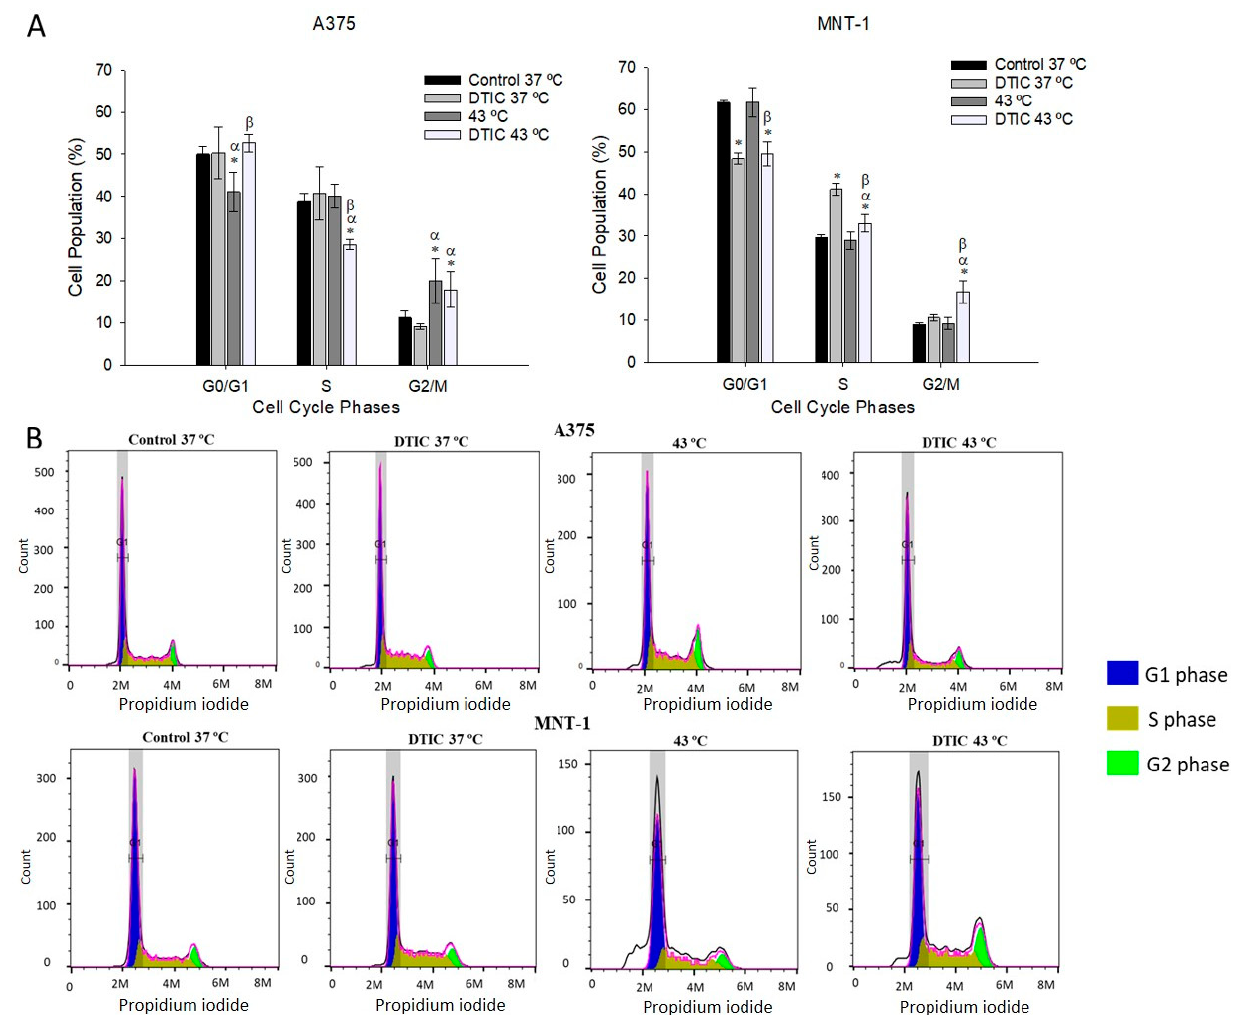
Figure 5. Cell cycle analysis of hyperthermia plus DTIC treated A375 and MNT-1 cells. Cells were exposed to 43 °C for 30 min and 5.5 μ g/mL or 115 μ g/mL of DTIC, in case of A375 or MNT-1 cells, respectively. ( A ) Cell cycle distribution (%) of both cell lines; ( B ) representative histograms of A375 and MNT-1 cell cycle analysis based on DNA content quantification using propidium iodide staining (arbitrary units). Data shown are the mean values ± standard deviation of two independent experiments, with two technical replicates each, and each replicate with at least 5000 events. *indi- cates statistical significance in comparison to the control 37 °C, α indicates statistical significance in comparison to the respective condition at 37 °C, and β indicates statistical significance of the condi- tions with hyperthermia in comparison to hyperthermia alone ( p < 0.05).